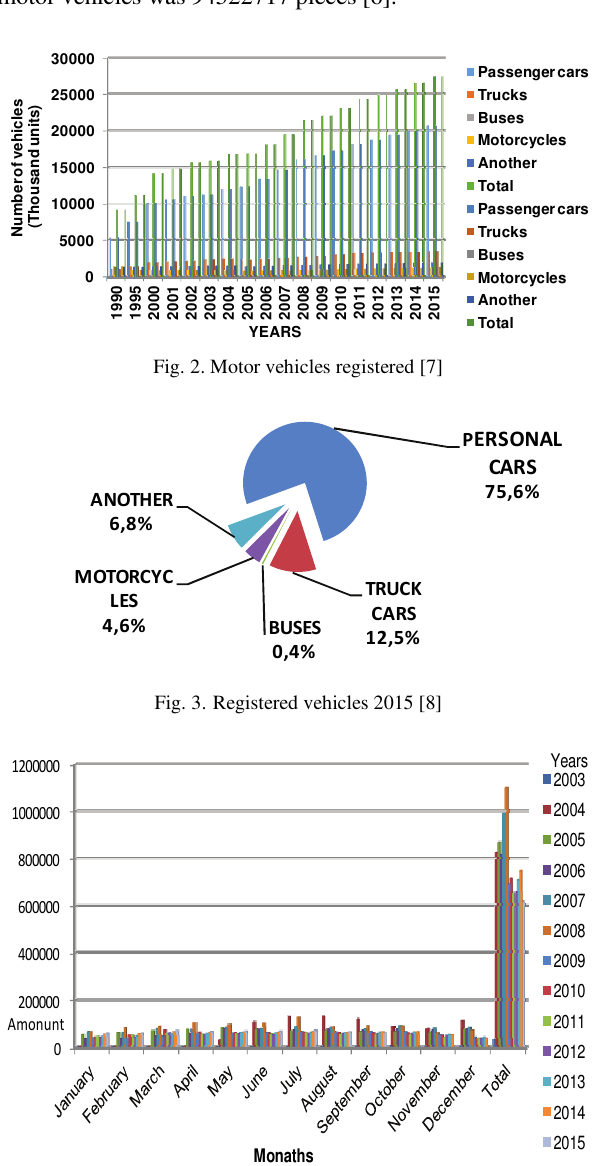
Fig. 4. Structure of used imported passenger cars [6]